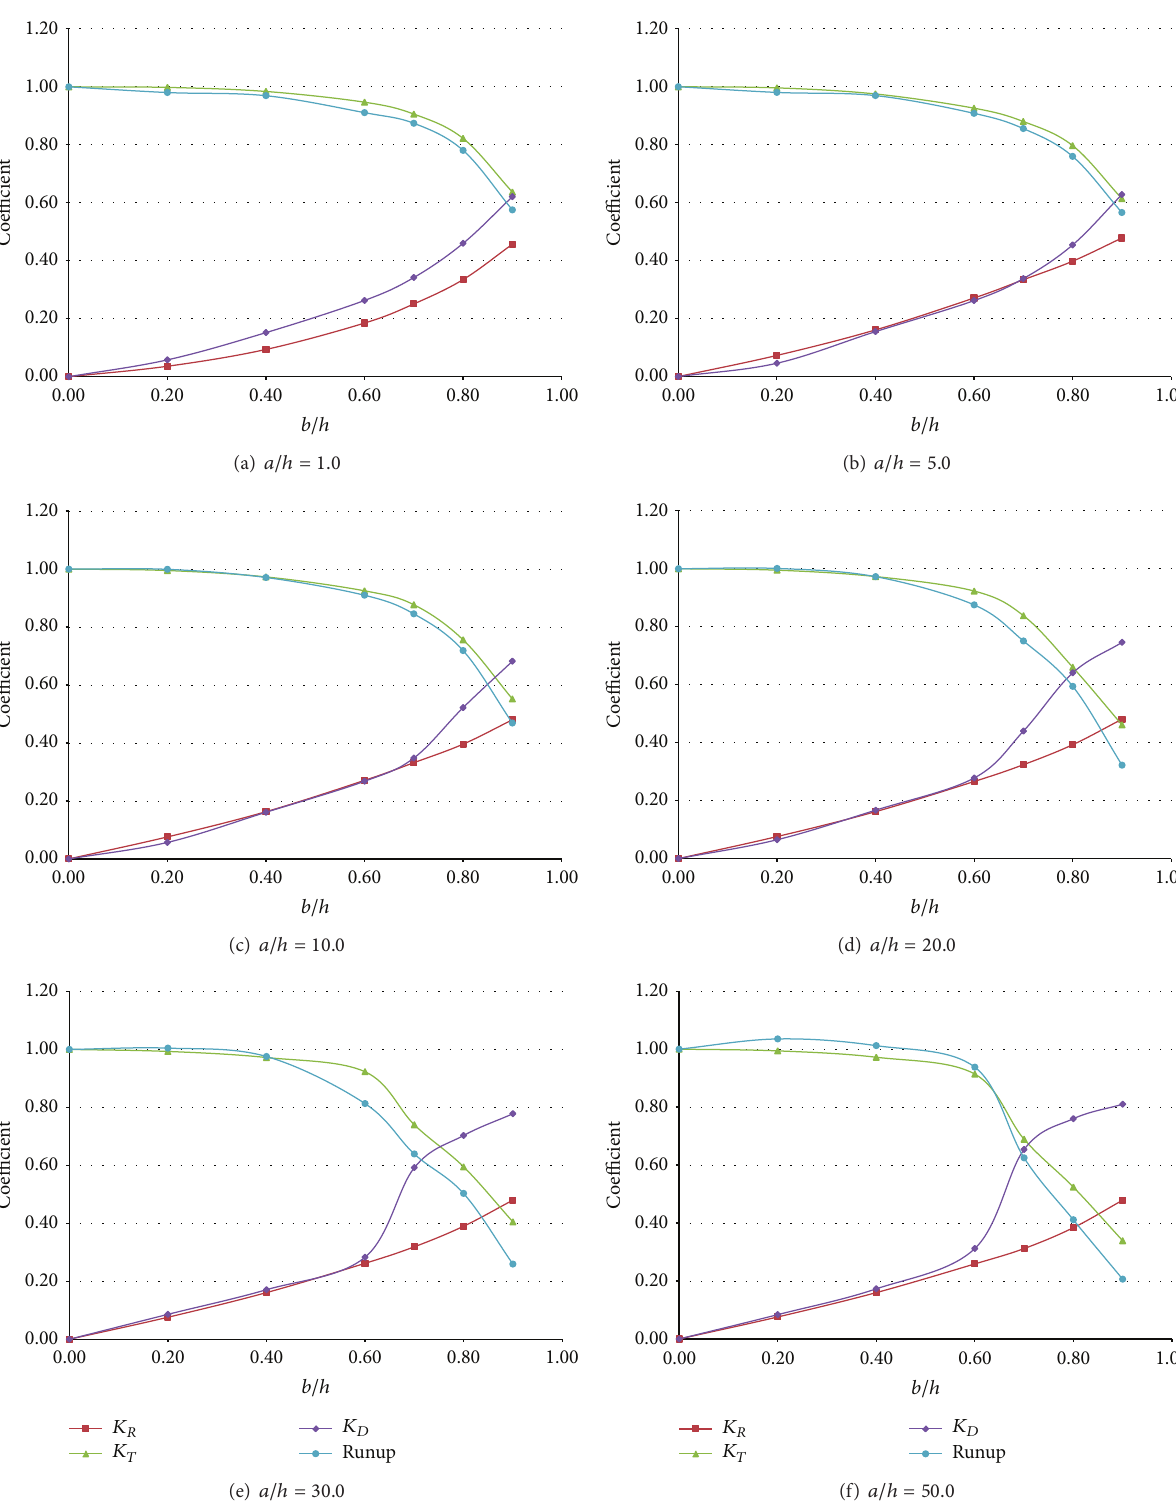
Figure 6: Variation of the RTD coefficients for different submerged structures (𝐻/ℎ = 1.0)